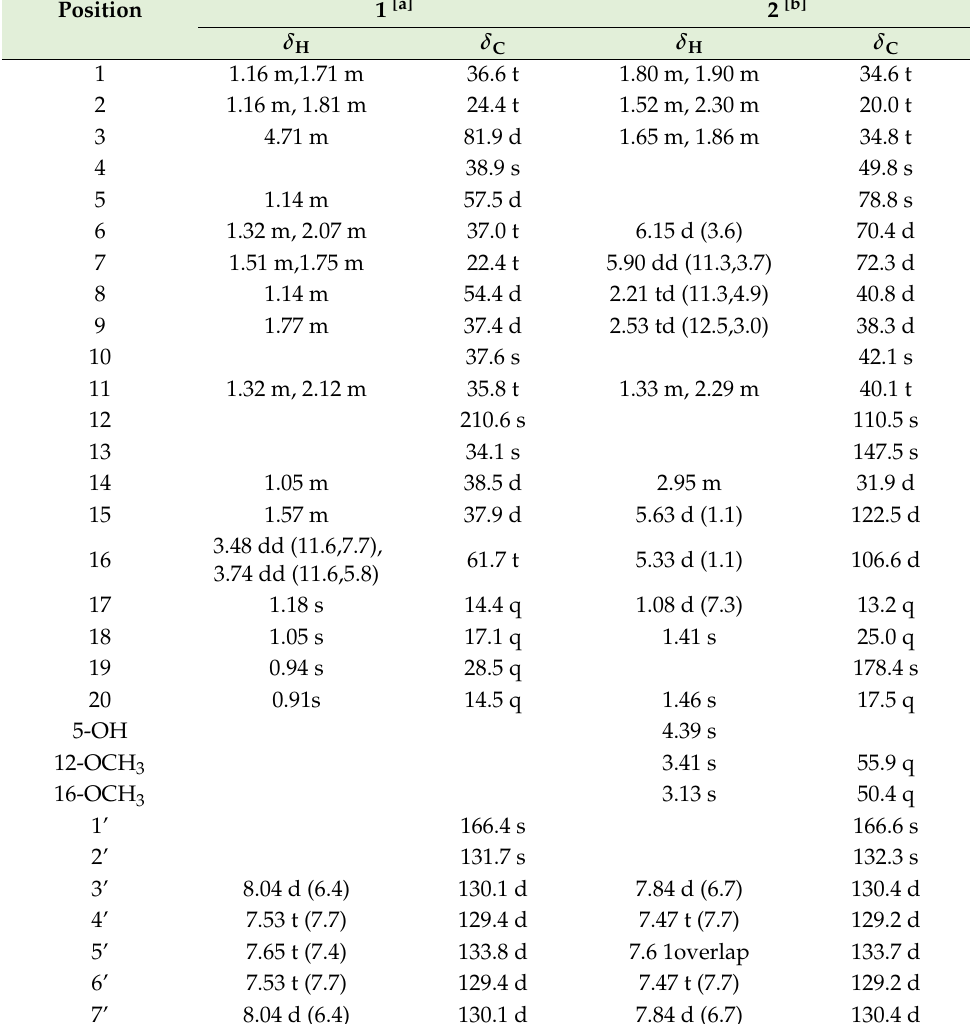
Table 1. 1 H and 13 C NMR spectroscopic data of compounds 1 and 2 ( δ H, δ C [ppm], J [ Hz]).